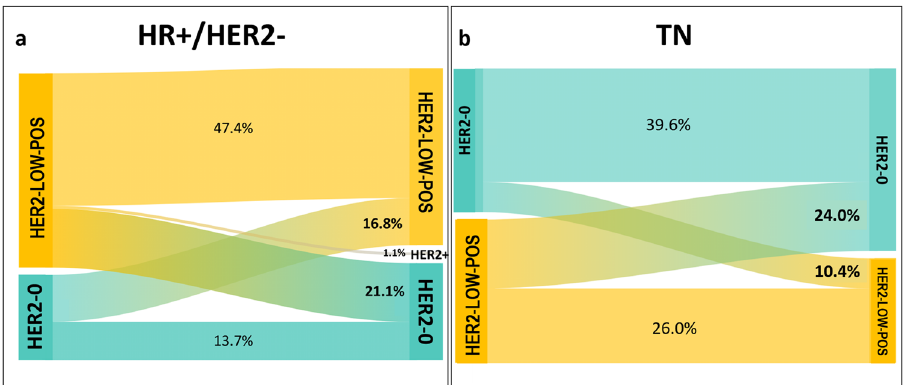
Fig. 4 Evolution of HER2 expression according to breast cancer subtype. These Sankey diagramas show the evolution of HER2 expression from baseline biopsy to residual disease after neoadjuvant chemotherapy in patients failing to achieve pCR in the HER2-negative cohort according to breast cancer phenotype. a Evolution of HER2 expression in HR + /HER2 + subtype; b Evolution of HER2 expression in TN subtype. HR + hormone-receptor positive, TN